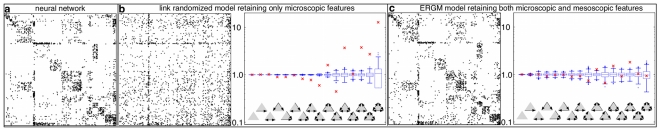
Motif counts in the synapse network of C. elegans compared to two random null models.
a) Adjacency matrix of the observed neural network [36]. b) Adjacency matrix of a typical realization of a link randomized version of the original data and resulting Z-score statistics of motif counts. Counts in the original data (red x) are compared to box plots of counts in 1000 link randomized null models. Strong deviations are found at 11 of the 16 motifs. Since the link randomized null models retain only node specific features, i.e. the numbers of incoming, outgoing and reciprocated links at each node, the cannot capture the apparent mesoscopic structure in the original network and hence may over-estimate the statistical significance of some motifs. c) Adjacency matrix of a typical network generated from a model similar (1) with both node specific as well as class specific parameters estimated from the original network. 15 classes were used in this example. Using 1000 networks generated from this model as a reference ensemble, the Z-score statistics show mild deviations only at 3 of the 16 motifs. This indicates that class structure may offer a more parsimonious explanation for the observed motif distribution.